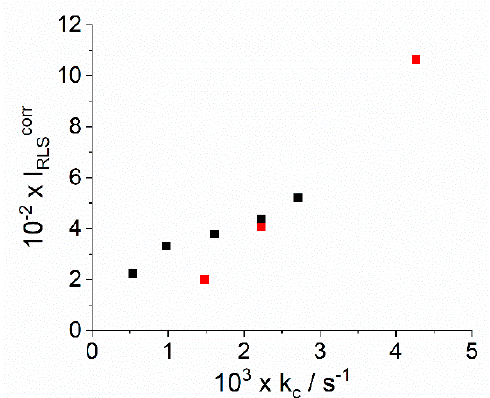
Figure 9. Plot of asymmetry g-factor as function of the corresponding ( a ) rate constants k c and ( b ) of the RLS intensity at maxima corrected for the extinction of the samples (black points at fixed ionic strength, red points at fixed pH). Int. J. Mol. Sci. 2020 , 21 , x FOR PEER REVIEW